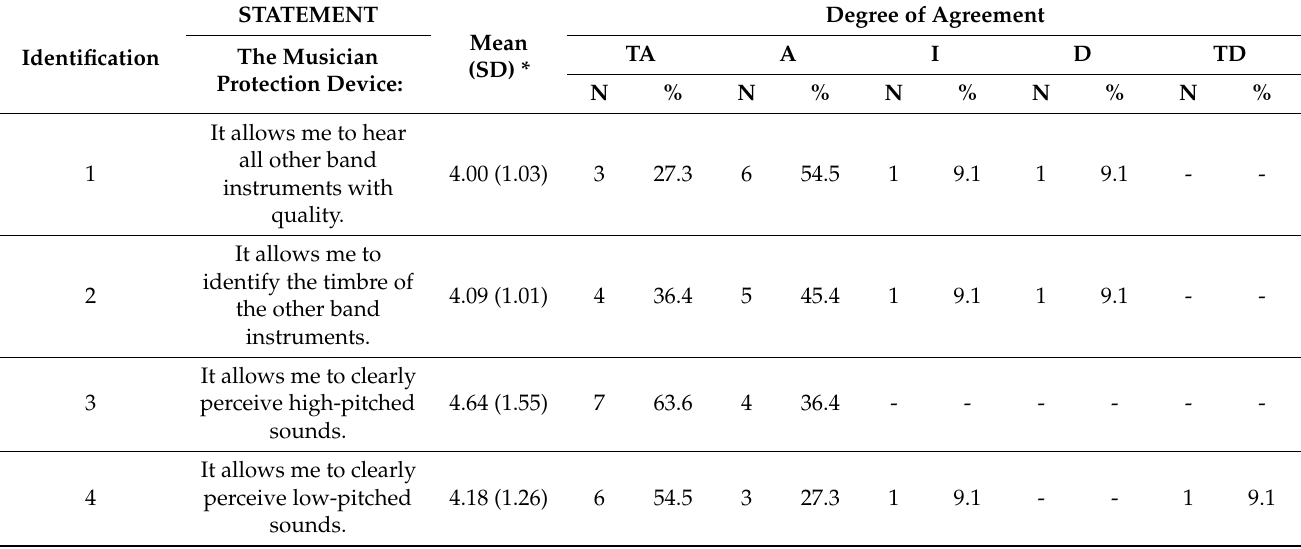
Table A5. Distribution of answers regarding the degree of agreement with each statement in the user satisfaction questionnaire with musician-specific hearing protection devices ( n =